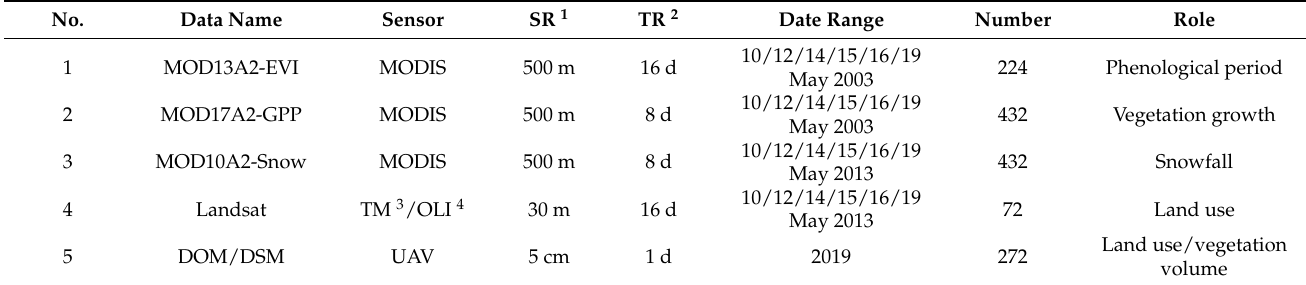
Figure 2. The flow chart of key research steps and multisource data. Table 1. Remote sensing data used in this